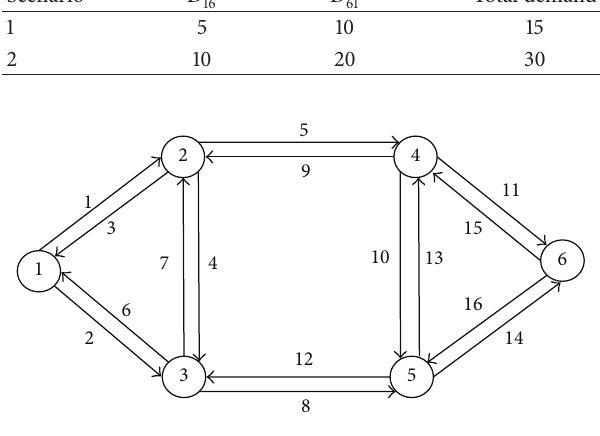
Figure 2: 16-link